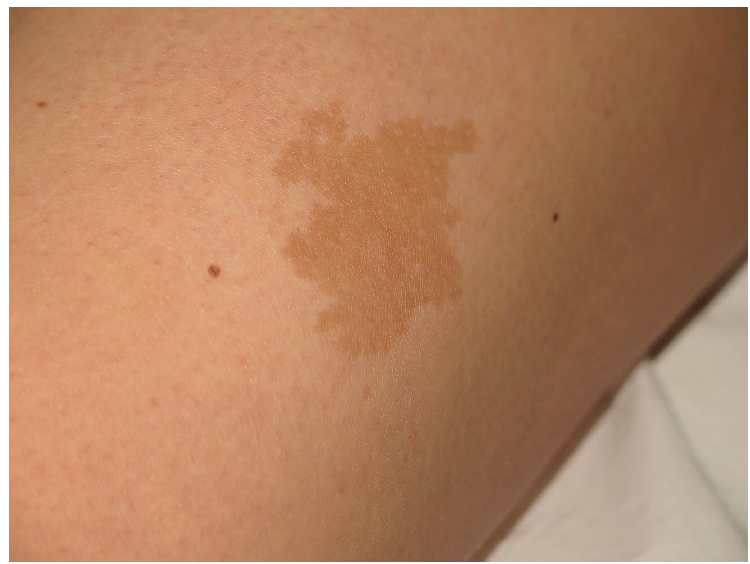
Figure 4. This CALM is not associated with NF1. It shows irregular borders and it is isolated.